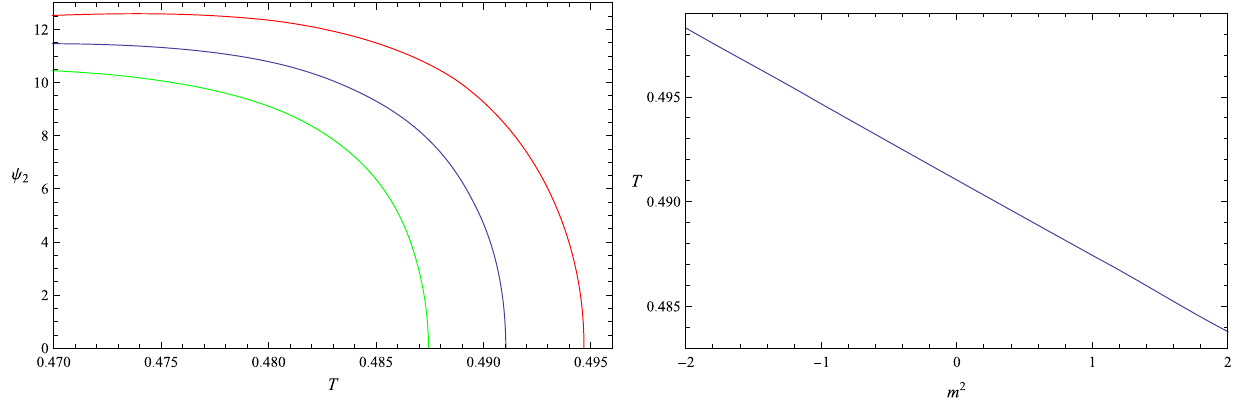
Fig. 6 In the left panel, we plot the parameter ψ 2 with respect to the temperature with q = 100, μ = 0 . 15 and various scalar masses m 2 from left to right: m 2 = − 1 (red), m 2 = 0 (blue) and m 2 = 1 (green).